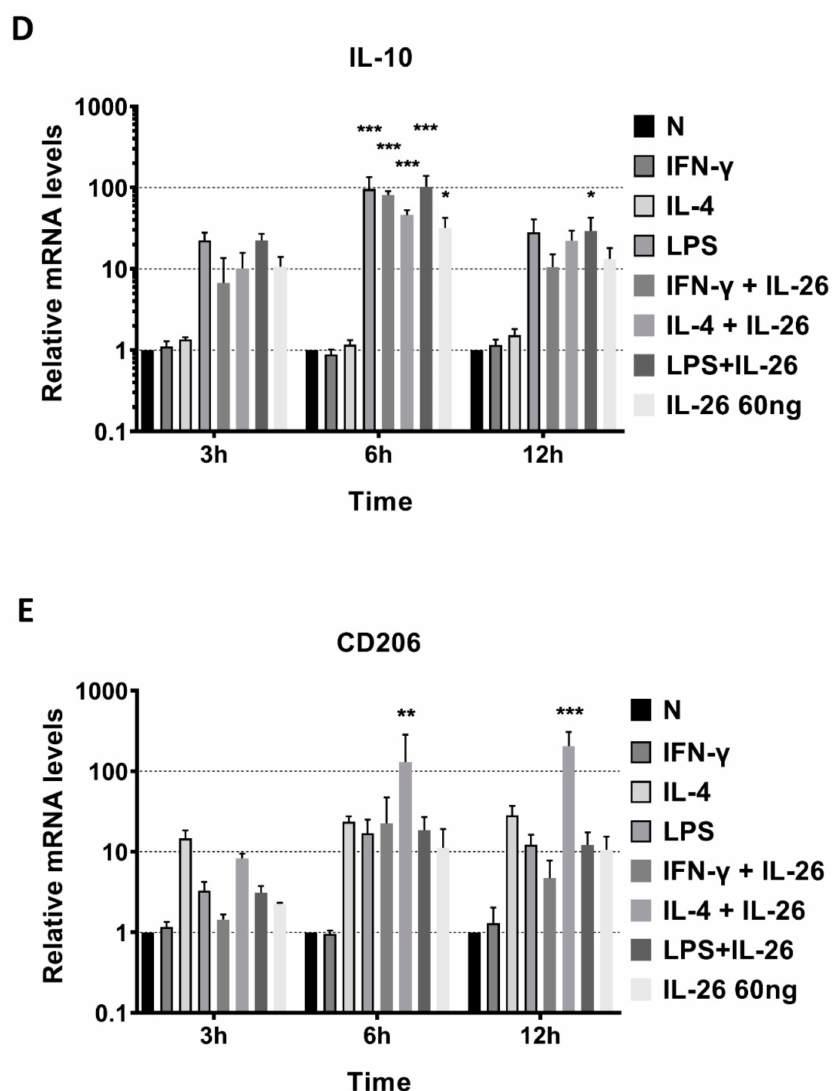
Figure 2. E ff ects of IL-26 on mRNA expression in M1 and M2 macrophage di ff erentiation. RAW264.7 cells were treated with IFN- γ (20 ng / mL), IL-4 (20 ng / mL), or LPS (10 ng / mL) in the presence or absence of IL-26 for 3, 6, and 12 h. Total RNA was isolated, and 1 µ g of total RNA was used to transcribe cDNA. cDNA was used as a template for PCR with mouse-specific primers. M1 macrophage gene markers ( A ) CD80, ( B ) TNF- α , or ( C ) iNOS, and M2 macrophage gene markers ( D ) IL-10 or ( E ) CD206 were detected by QPCR. Results are the means ± SD of three independent experiments. (* p < 0.05, ** p < 0.01, *** p <